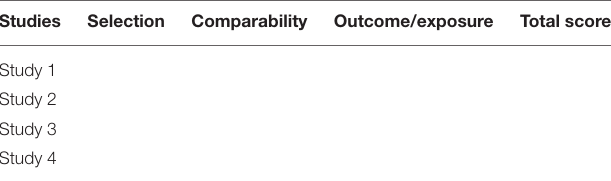
TABLE 2 | Risk of bias assessment in individual studies, using the Newcastle-Ottawa Scale *